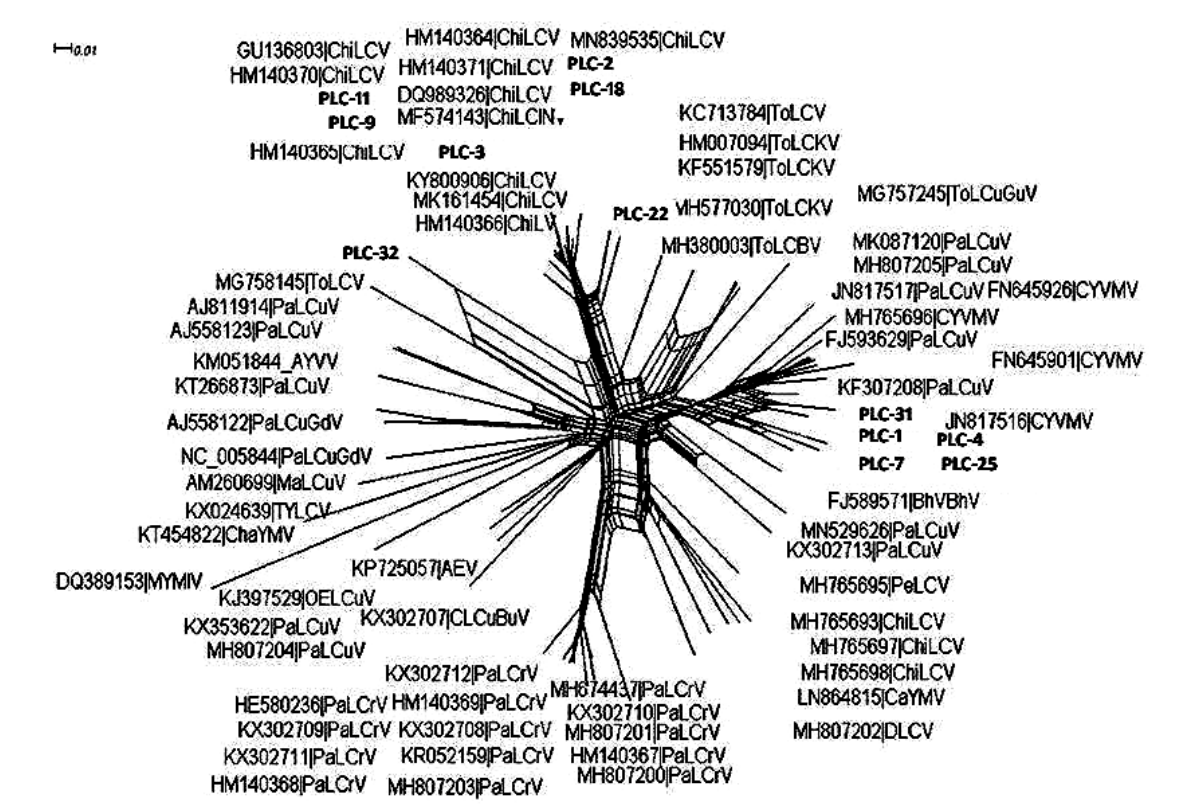
Figure 5. Neighbor–net generated for papaya-infecting begomoviruses has shown significant signals for phylogenic conflict with other previously known begomoviruses indicating the presence of recombinant begomoviruses.